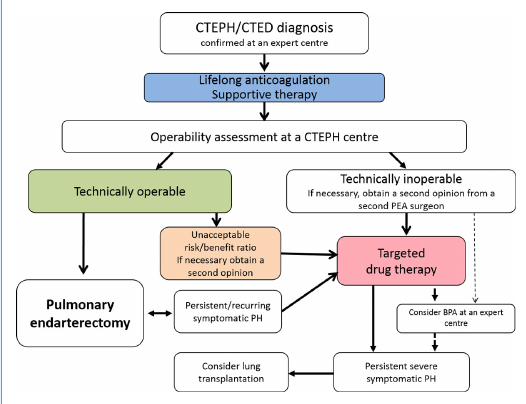
Figure 14: CTEPH Treatment algorithm recommendation accord- ing to consenus conference Cologne. Wikens H et al.,